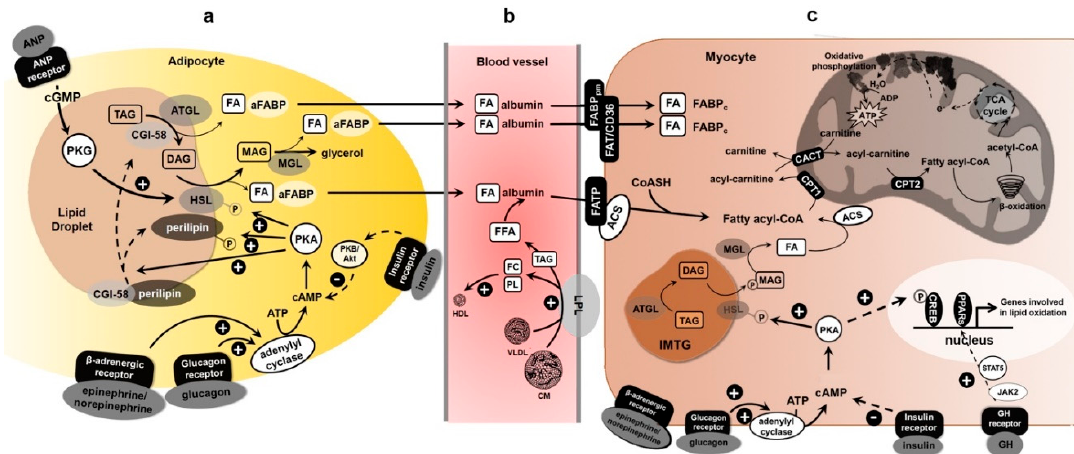
Figure 1. Fatty acid mobilization and utilization in skeletal muscle during endurance exercise. ( a ) Epinephrine (as well as norepinephrine) and glucagon stimulate FA release from TG stored in adipocyte lipid droplets, with insulin countering their actions. Epinephrine and glucagon bind their specific receptor in the adipocyte membrane, thus stimulating adenylyl cyclase to produce cyclic AMP (cAMP). cAMP activates the cAMP-dependent protein kinase (PKA), which phosphorylates both HSL and perilipin present on the surface of the lipid droplet. The phosphorylation of perilipin increases ATGL activity, thereby providing more diacylglycerol (DAG) substrates to hormone-sensitive lipase (HSL). Hormone-sensitive lipase then hydrolyzes DAG to a free fatty acid (FFA) and MAG, which is further hydrolyzed by a monoacylglycerol lipase (MGL). FFAs are transported to the plasma membrane bound to adipocyte fatty acid-binding protein (aFABP), leave the adipocyte, and bind serum albumin in the blood. ( b ) Exercise induces lipoprotein lipase (LPL) on the surface of endothelial cells of skeletal muscle. The increased LPL activity increases TG hydrolysis from TG-rich lipoproteins (such as chylomicrons (CM) and very-low density lipoproteins (VLDL)), thus releasing FFA, glycerol, free cholesterol (FC) and phospholipids (PL). The esterified cholesterol is packaged into the core of HDL particles, increasing plasma HDL-C levels. ( c ) FFA derived from lipoproteins and adipocyte lipolysis are released from the albumin and enter myocytes via specific fatty acid transporters, such as fatty acid translocase (FAT / CD36), plasma membrane-associated fatty acid binding proteins (FABP pm ) and fatty acid transport proteins (FATP). Long-chain FAs bind directly to FATP closely associated with sarcolemmal acyl-Coenzyme A synthethase (ACS). Alternatively, FAs may first bind to FAT / CD36 and then be delivered either to FATP or to cytosolic fatty acid binding proteins (FABP) and activated into acyl-Coenzyme A (acyl-CoA) by intracellular ACS. Acyl-CoA esters enter the mitochondrion via carnitine palmitoyl transferase 1 (CPT1) and are cleaved in the β -oxidation pathway. The acetyl-Coenzyme A molecules produced are oxidized through the tricarboxylic acid cycle (TCA), and the energy of oxidation is conserved in ATP, which fuels muscle contraction and other energy requiring metabolism in the myocyte. FA released from intramyocellular triacylglycerol store (IMTG) through local HSL activity also contribute to lipid utilization in the myofibers during this exercise type.